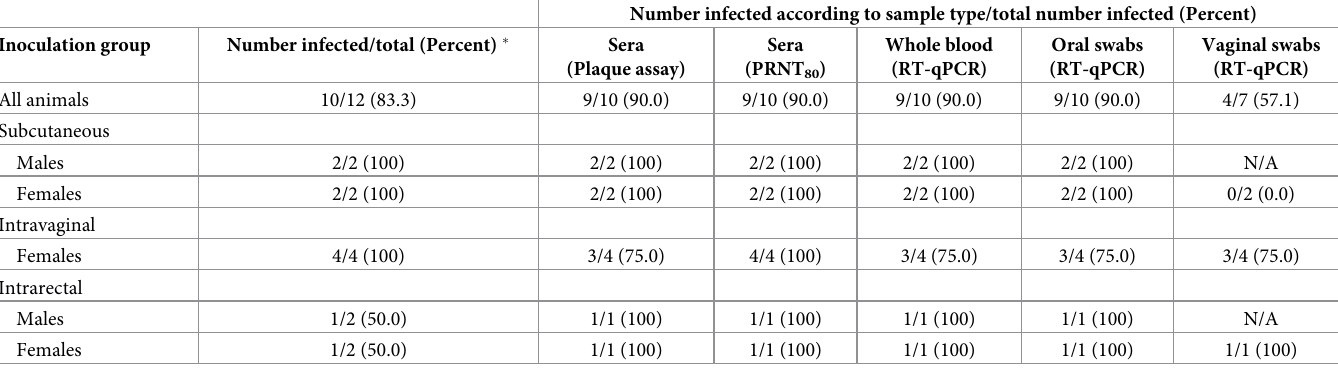
Table 6. Detection of viremia, viral RNA and virus-specific neutralizing antibodies in Zika virus-infected African green monkeys. Number infected according to sample type/total number infected